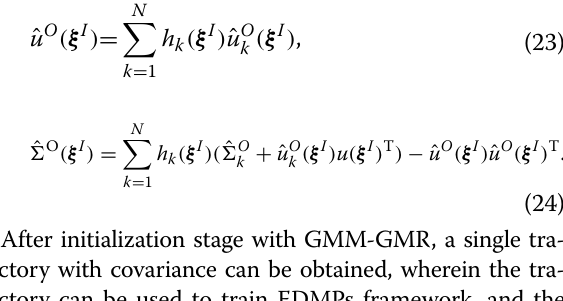
After initialization stage with GMM-GMR, a single tra- jectory with covariance can be obtained, wherein the tra- jectory can be used to train EDMPs framework, and the covariance can be applied to estimate the stiffness matrices K i ∈ R 6 × 6 of impedance control loop.